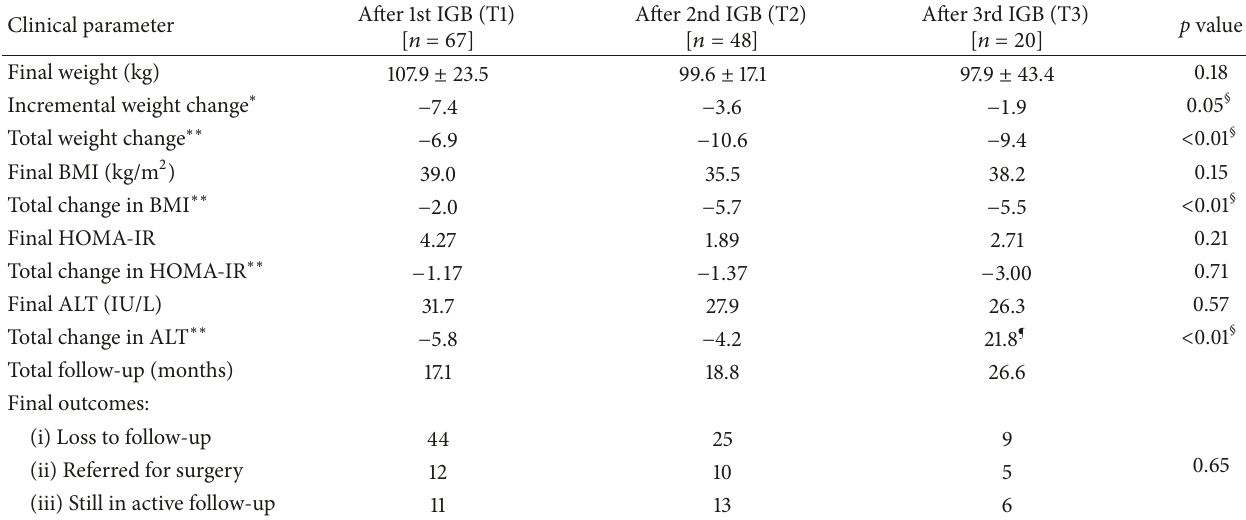
Table 3: Anthropometric and ALT changes following serial IGB therapy.